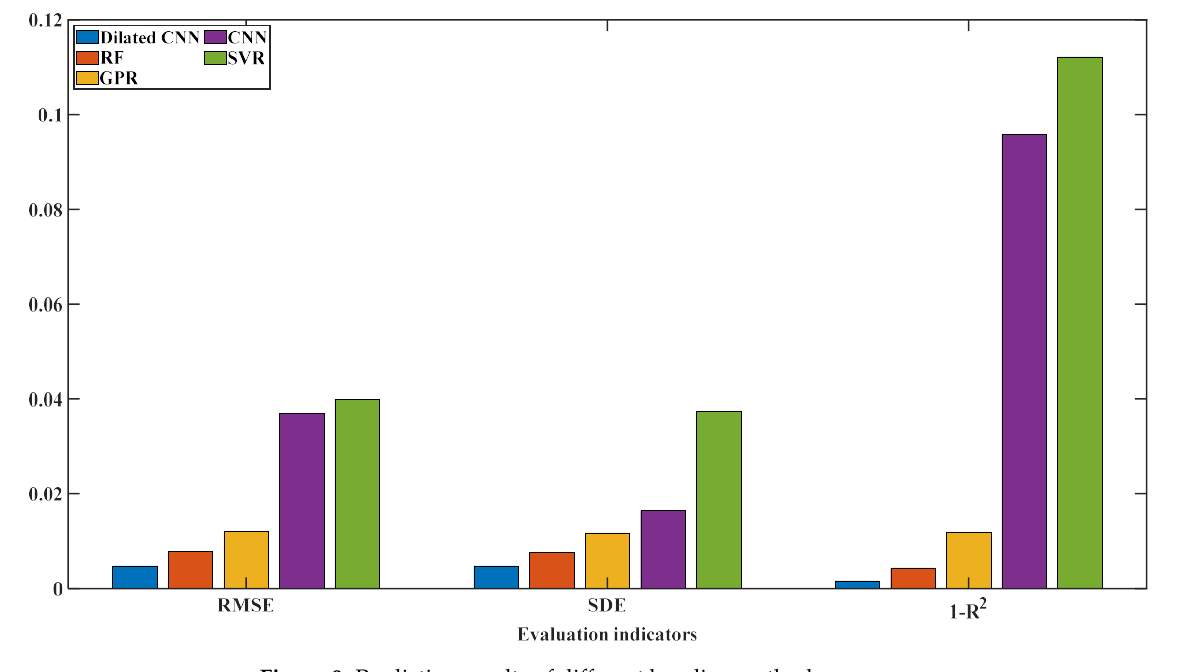
Figure 9. Prediction results of different baseline methods.